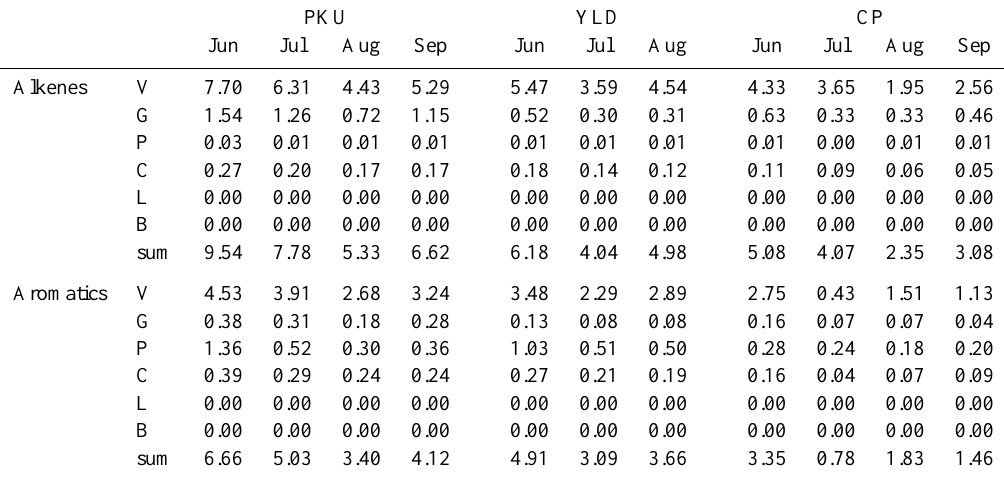
Table 6. Calculated source contributions to alkenes and aromatics in June, July, August, and September (Unit: ppbv). PKU YLD CP